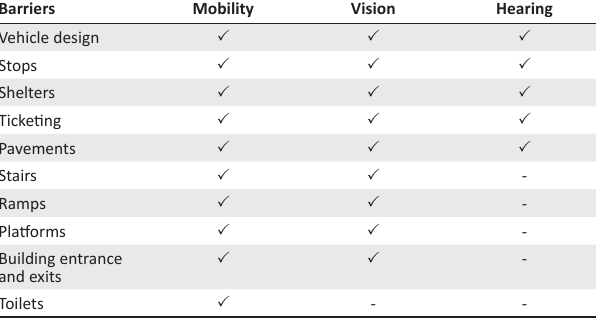
TABLE 2: Summary of structural barriers.